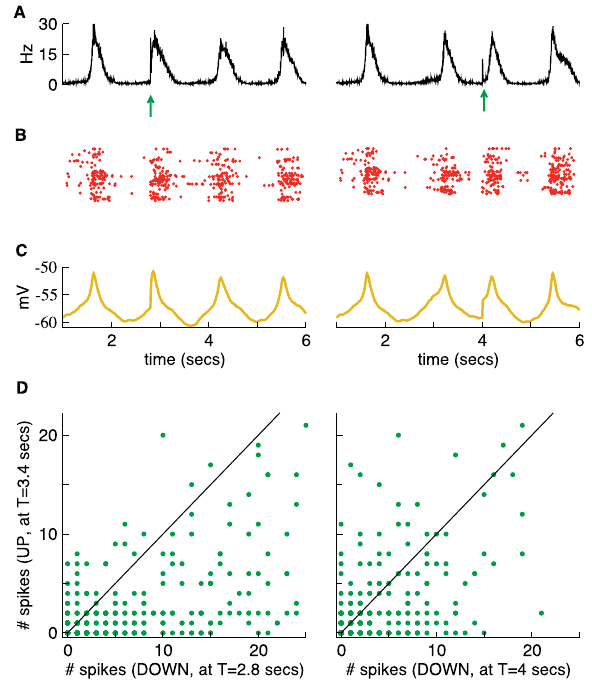
Figure 12. Dependence of the spiking responses on network state . This is the same network as in Figure 11 , but now the stimulus is applied during the first down state at t=2.8seconds (left) and during the second down state at t=4s (right). (A) Population rates. (B) Rastergrams. (C) Average membrane potentials. (D) These graphs compare the number of spikes produced by individual neurons when the network was stimulated during the down states (as in the upper panels) compared to those produced by stimulating during the up state (as in Figure 11 , right). Spikes are counted within a time window of 200ms following the application of the